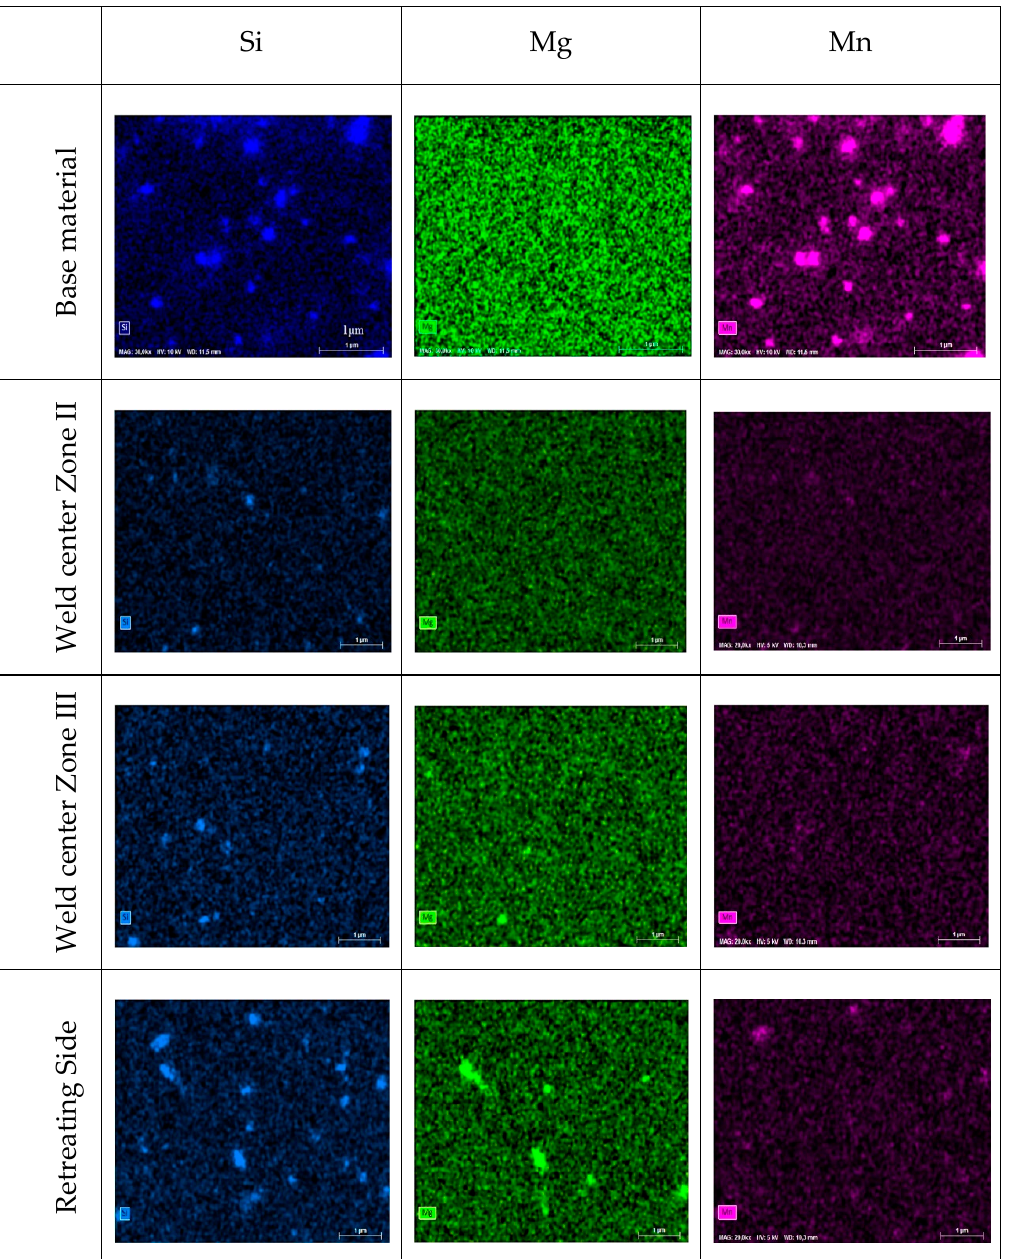
Figure 11. EDS map of Si, Mn, and Mg distribution in different areas of the WN.